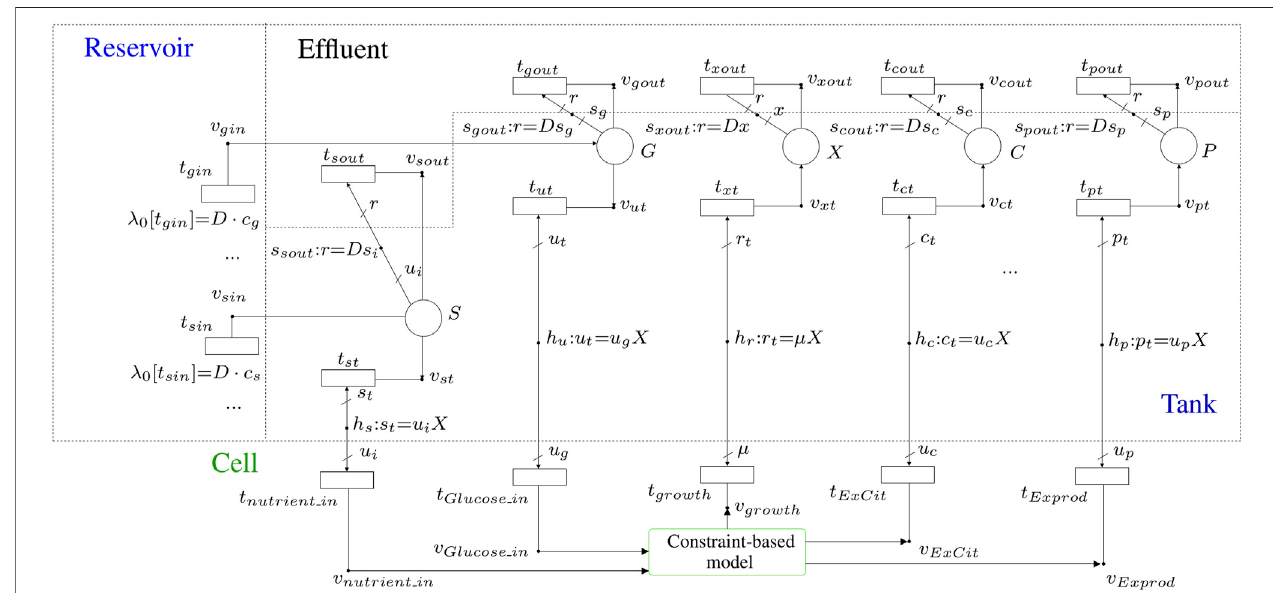
FIGURE 5 | FN modeling the overall production system by integrating the macroscopic model of the bioreactor and the microscopic model of the constrained- based model, MODEL1108160000 Orth et al. (2011) of the BioModels database Malik-Sheriff et al. (2020), of the cultured organism.